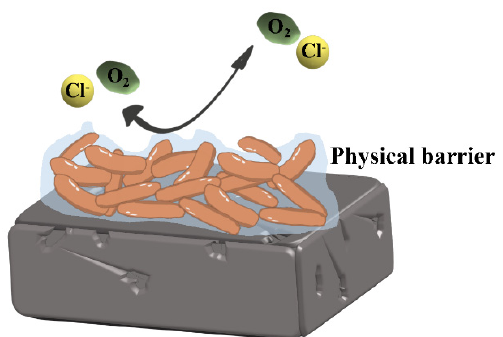
Figure 7. Proposed mechanism of corrosion inhibition of Bacillus sp. Y-6 and T. mesophilum D-6 biofilms on metal surfaces. The biofilm formed on the metal surface blocks corrosive reagents.